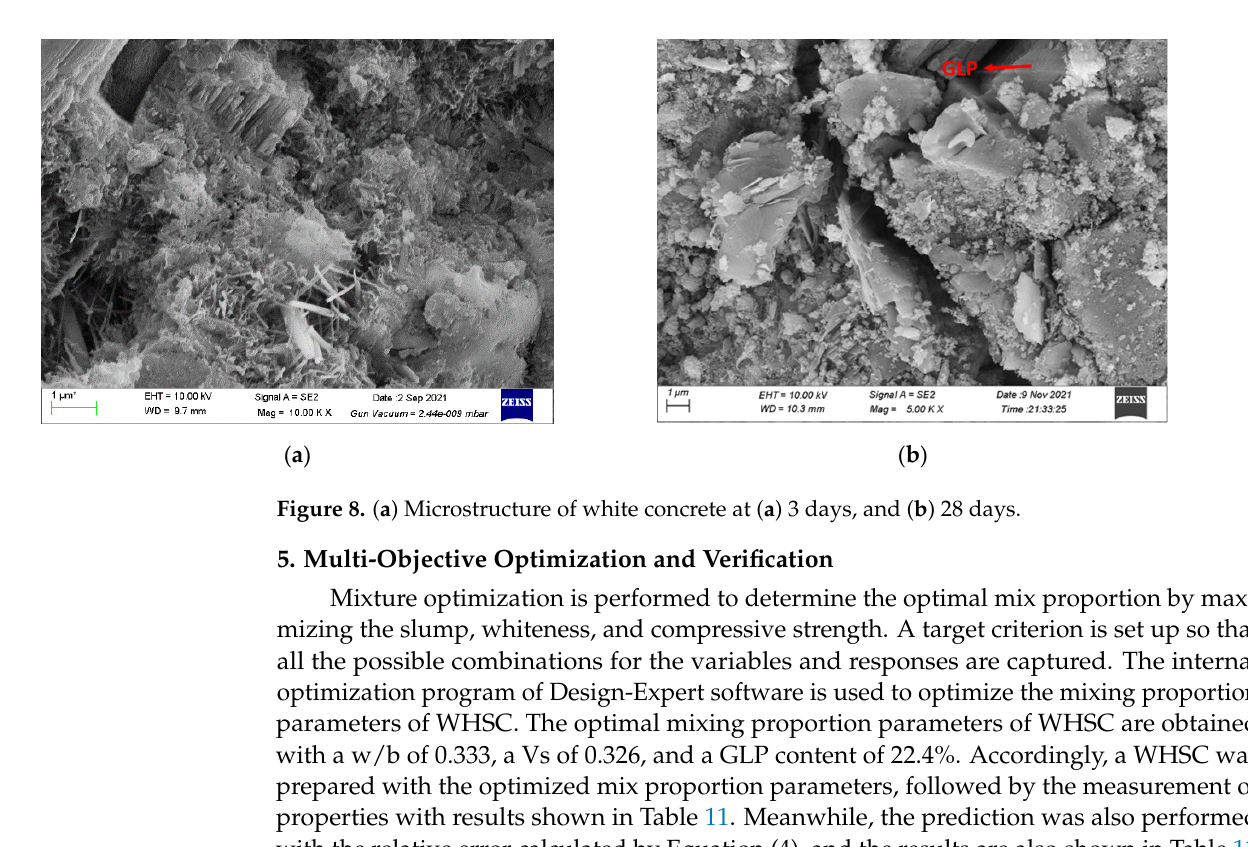
Table 11. Comparison of predicted values (pred.) and measured values (meas.) after parameter